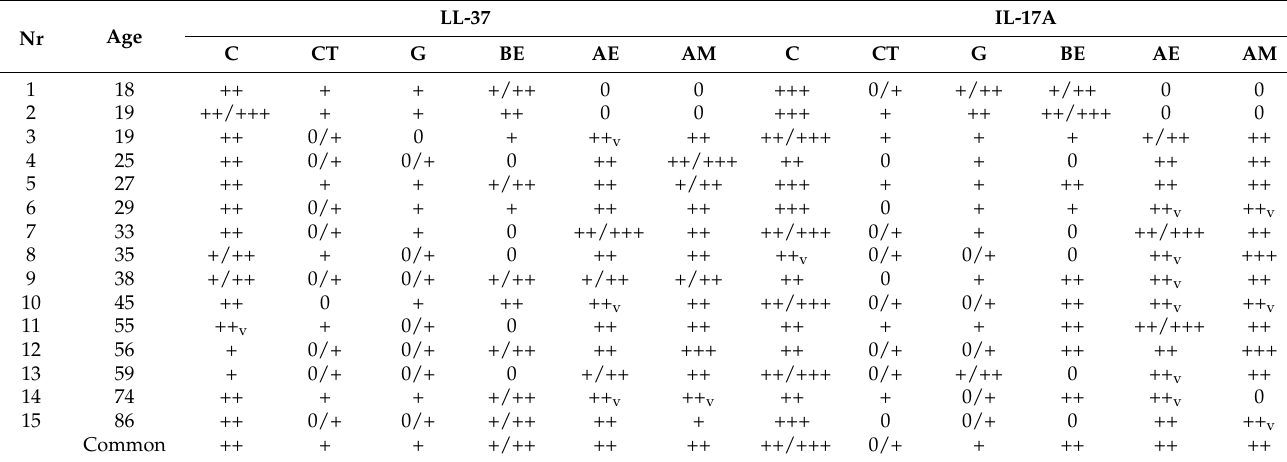
Table 3. Relative number of cathelicidine and IL-17A-positive structures in the healthy lung structures: cartilage, connective tissue, glands, bronchial epithelium, alveolar macrophages and alveolar